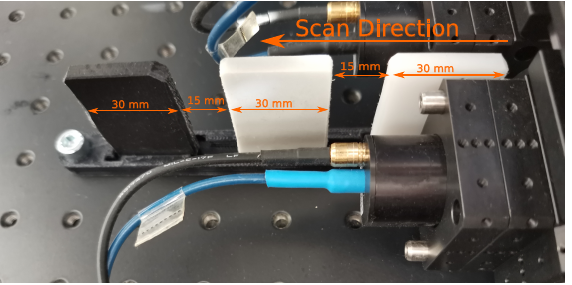
Figure 5. Plastic samples in grey, black and white color. The dimensions of the plastic samples were 30 × 45 mm with 5 mm